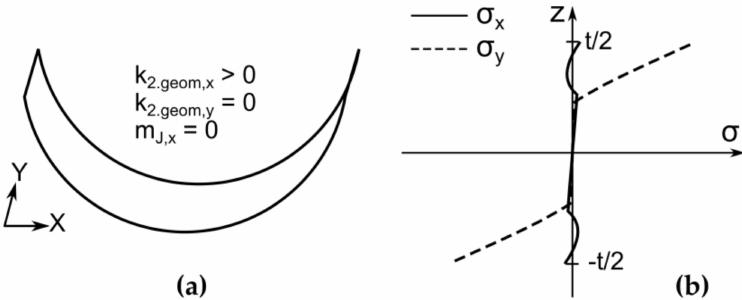
Figure 10. Shell geometry ( a ) and stress distribution along the shell thickness ( b ) at second stable state.